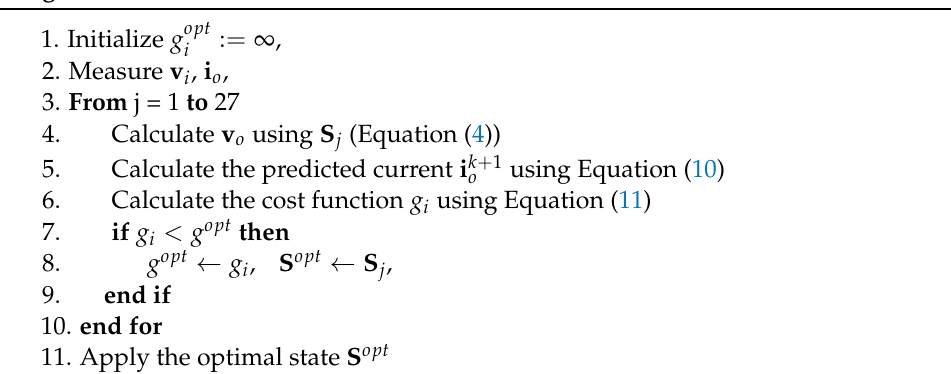
Algorithm 2: Predictive current control in